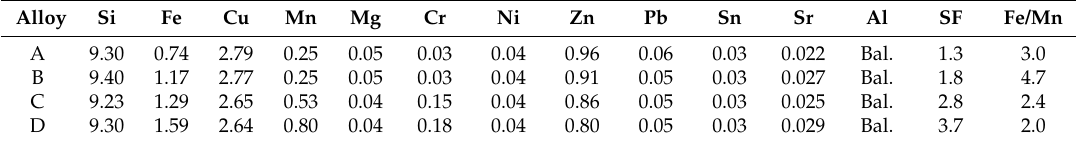
Table 1. Chemical composition of the alloys used in this study in wt. %, analyzed by OES.